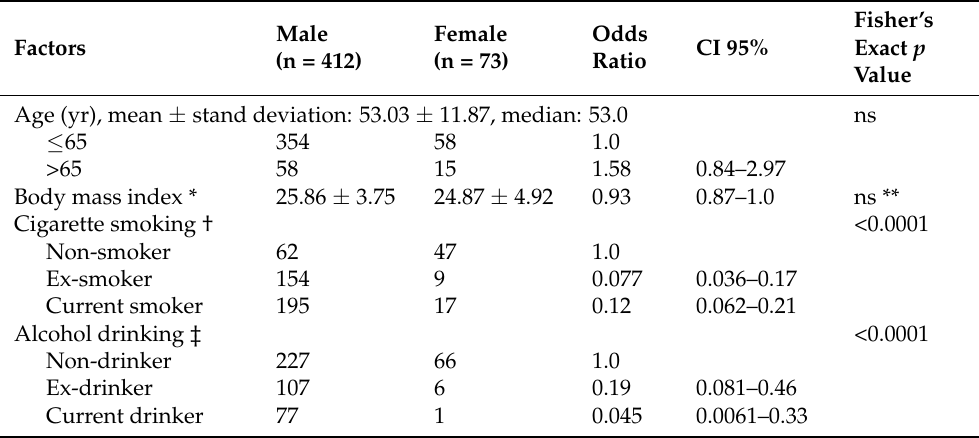
Table 1. The demographic data, and clinicopathological characteristics oral leukoplakia in male (n = 412) and female (n = 73)